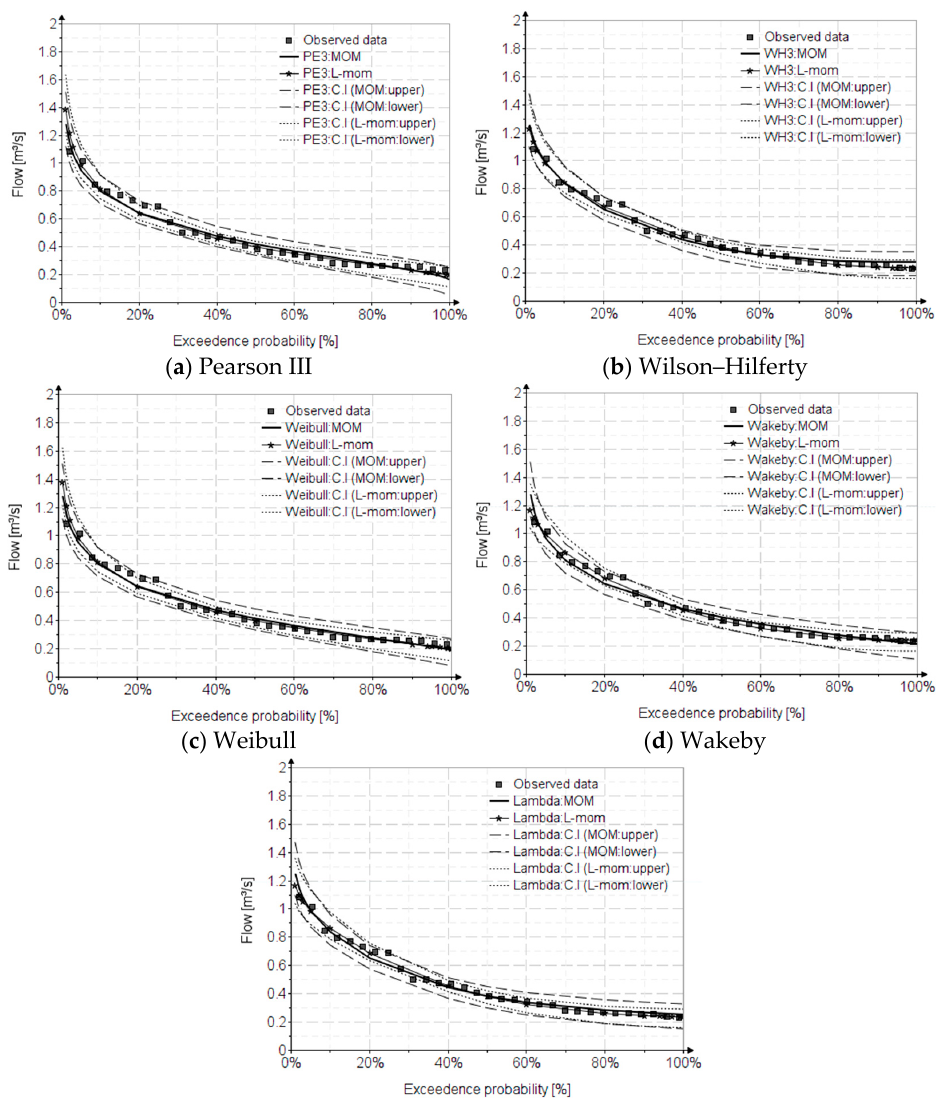
Figure 8. The probability distribution curves for minimum 30 ‐ day low flows.